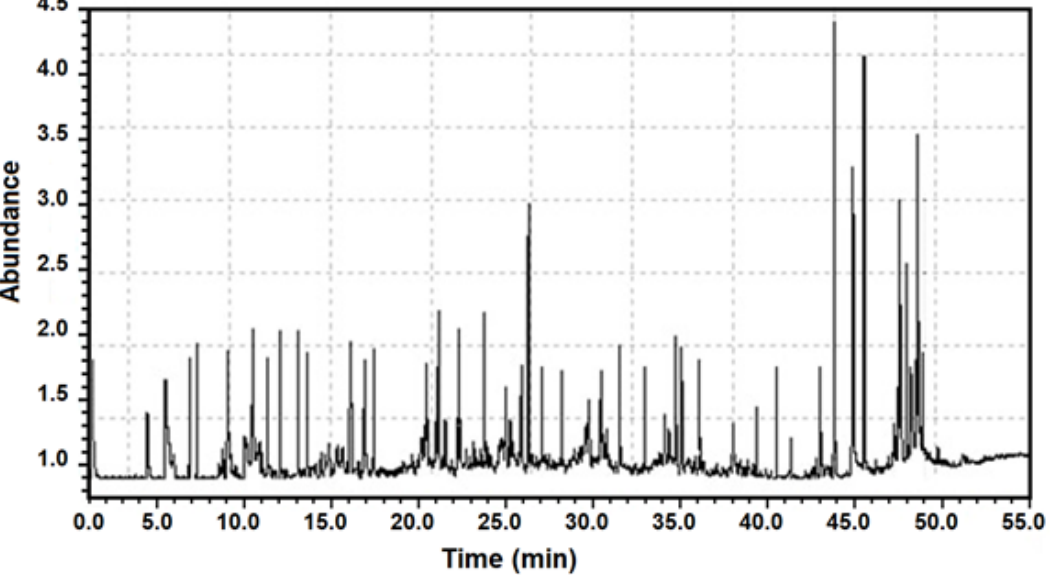
Figure 2. Gas Chromatogram and Mass spectrometry (GC-MS) chromatogram of SSP.